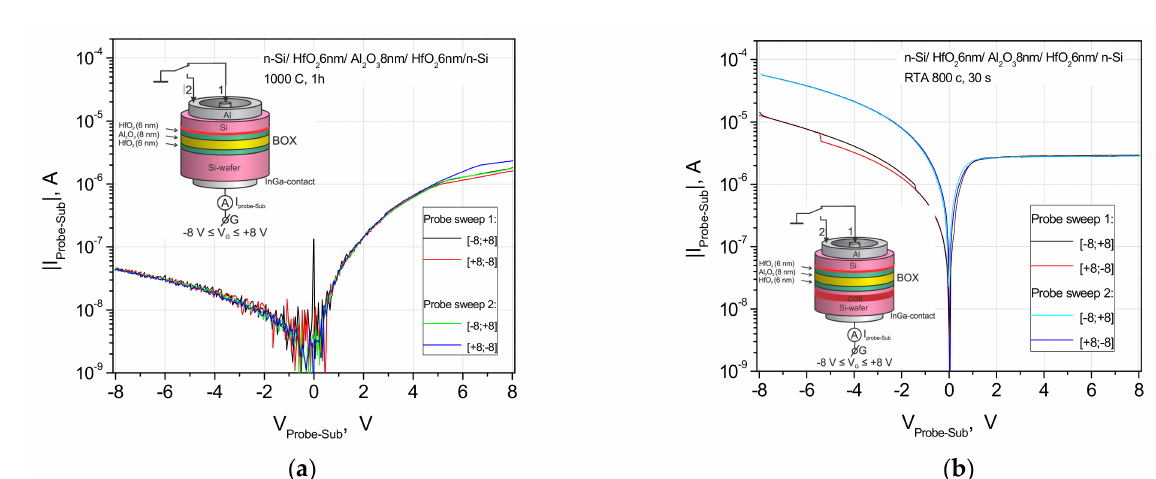
Figure 6. ( a ) Diode-like current-voltage (I-V) characteristics at the source–gate contacts and drain-gate contacts of n-SIS Corbino structures on the wafers fabricated by the DeleCut method: 500 nm n-Si/HfO 2 6 nm / Al 2 O 3 8 nm/HfO 2 6 nm / n-Si- substrate, after the FA at 1000 ◦ C for 1 h; ( b ) the same, but with a CO + implanted getter (E CO+ = 90 keV, φ = 1 × 10 16 cm − 2 ) after the RTA at 800 ◦ C for 30 s. The bias voltage is applied to the n-Si substrate. In the insets are the measurement scheme and the n-SIS structure layers, where the bonding interface and COII getter are indicated by a red line and stripe,